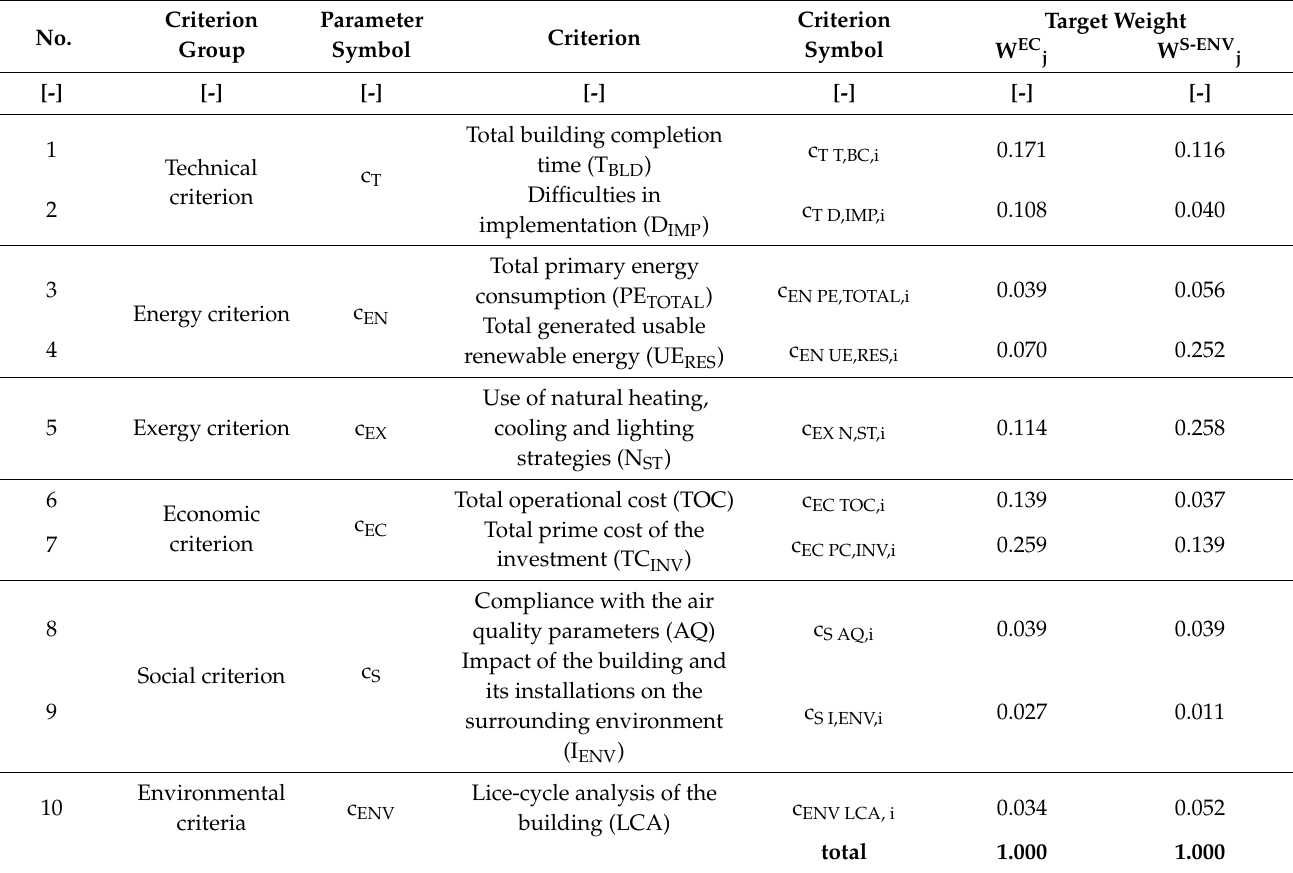
Table 5. Target weights for evaluation criteria by ‘economic preference’ and ‘socio-environmental